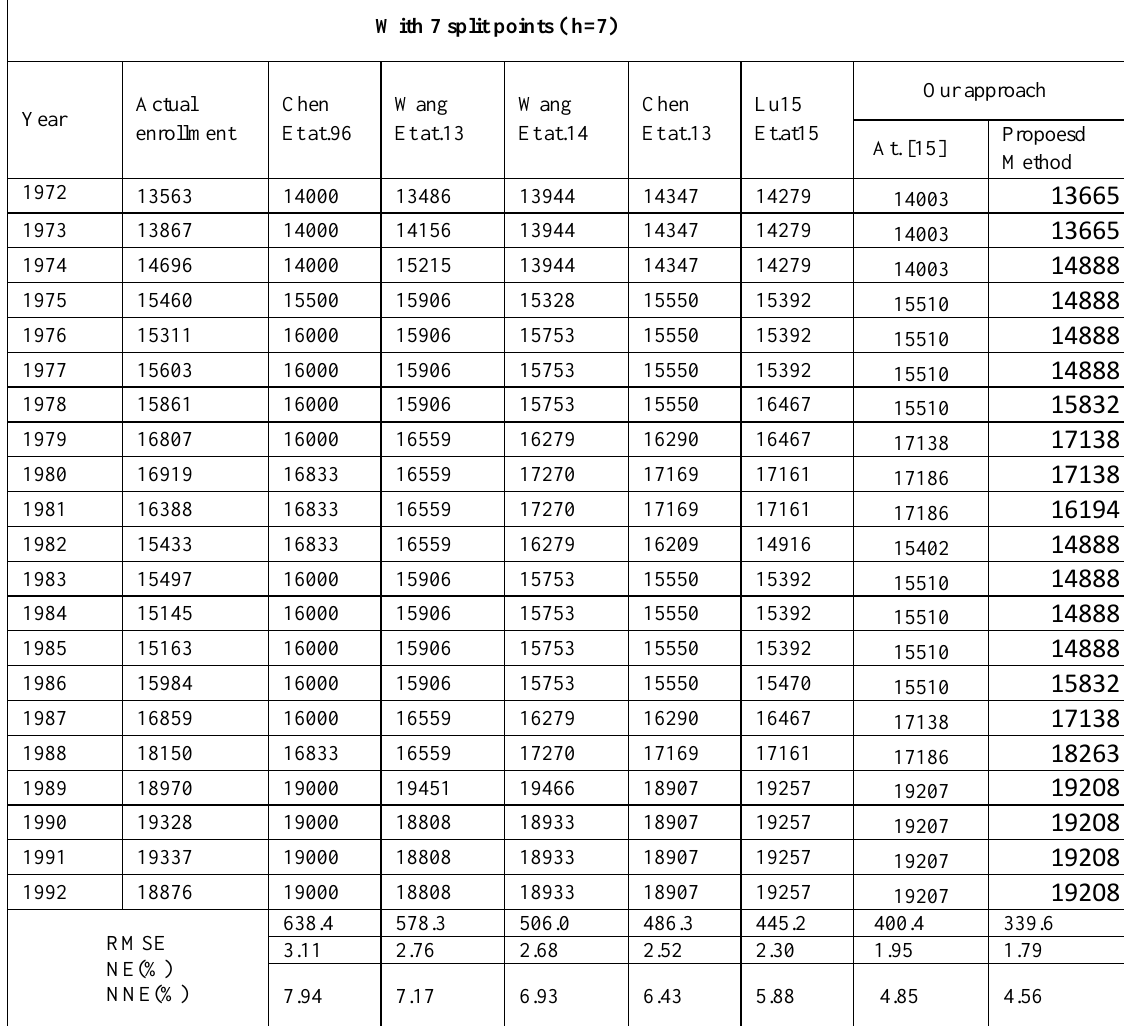
Table 4. Shown the detailed results of the proposed method and the preceding